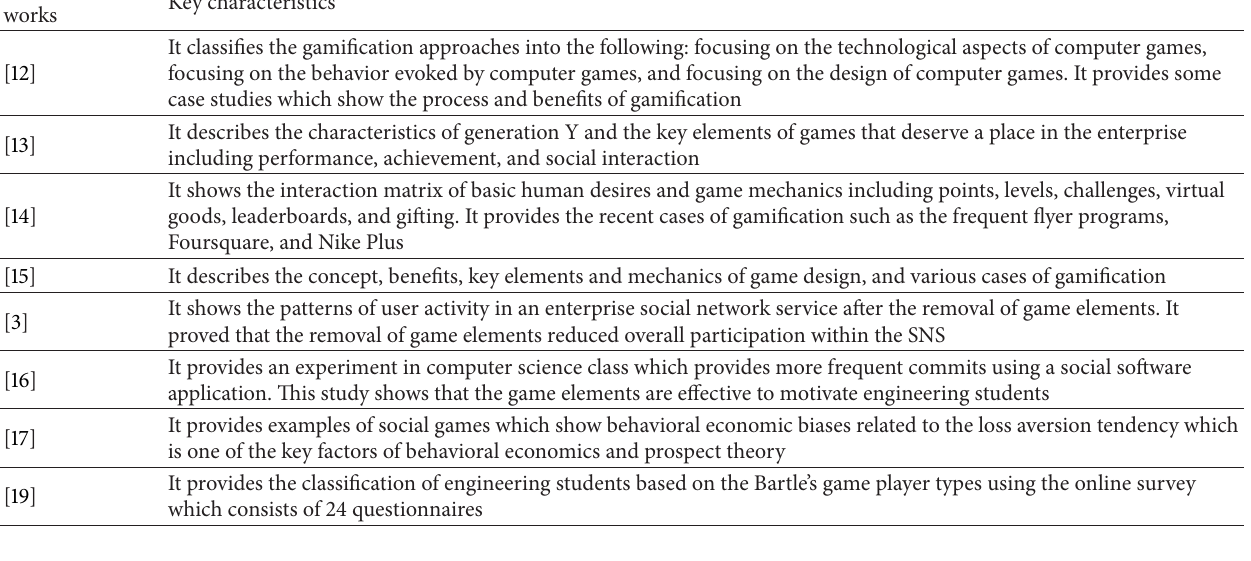
Table 1: Previous works on gamification.